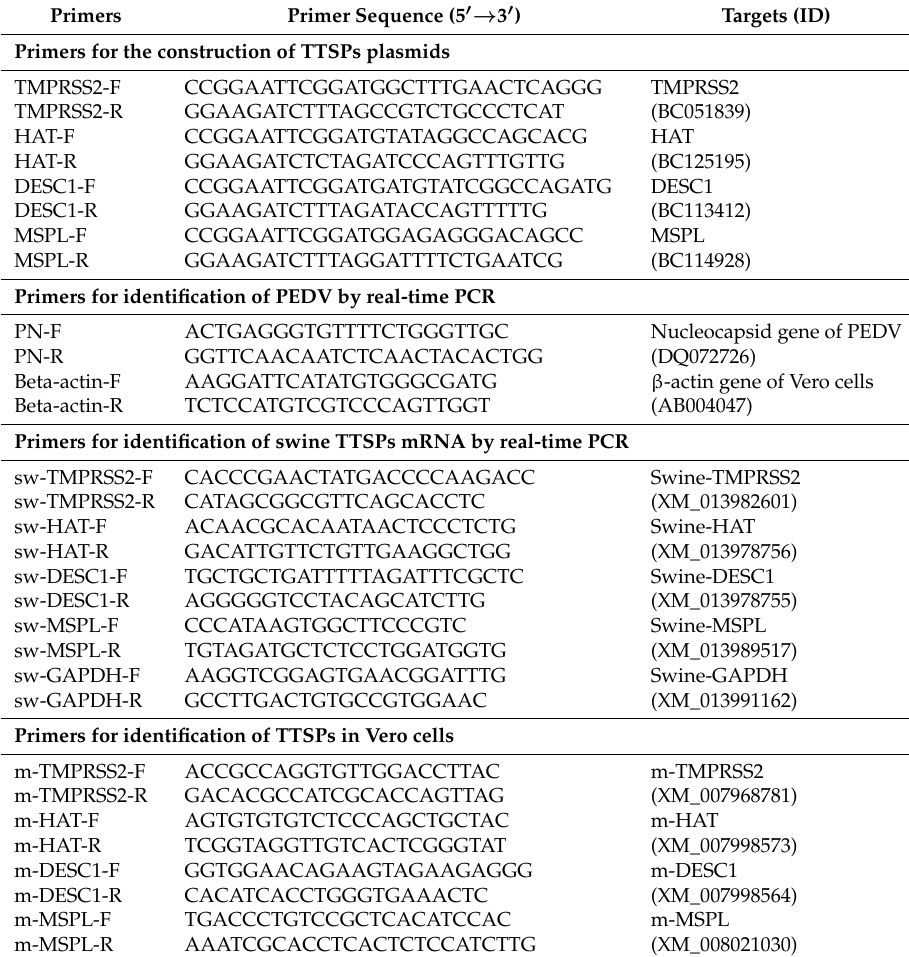
Table 1. Primers used in the